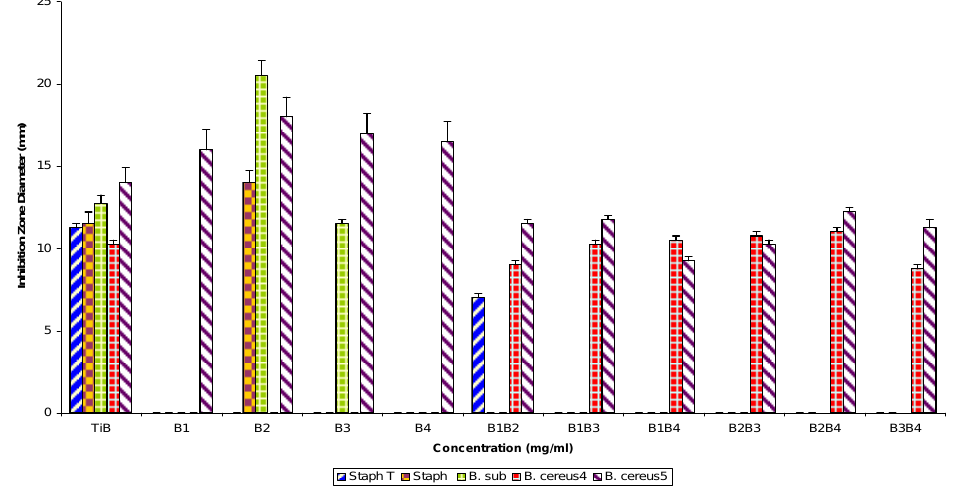
Figure 4. Antibacterial susceptibility pattern of Gram positive bacterial test strains to fraction TiB, its refraction products singly and in combination.